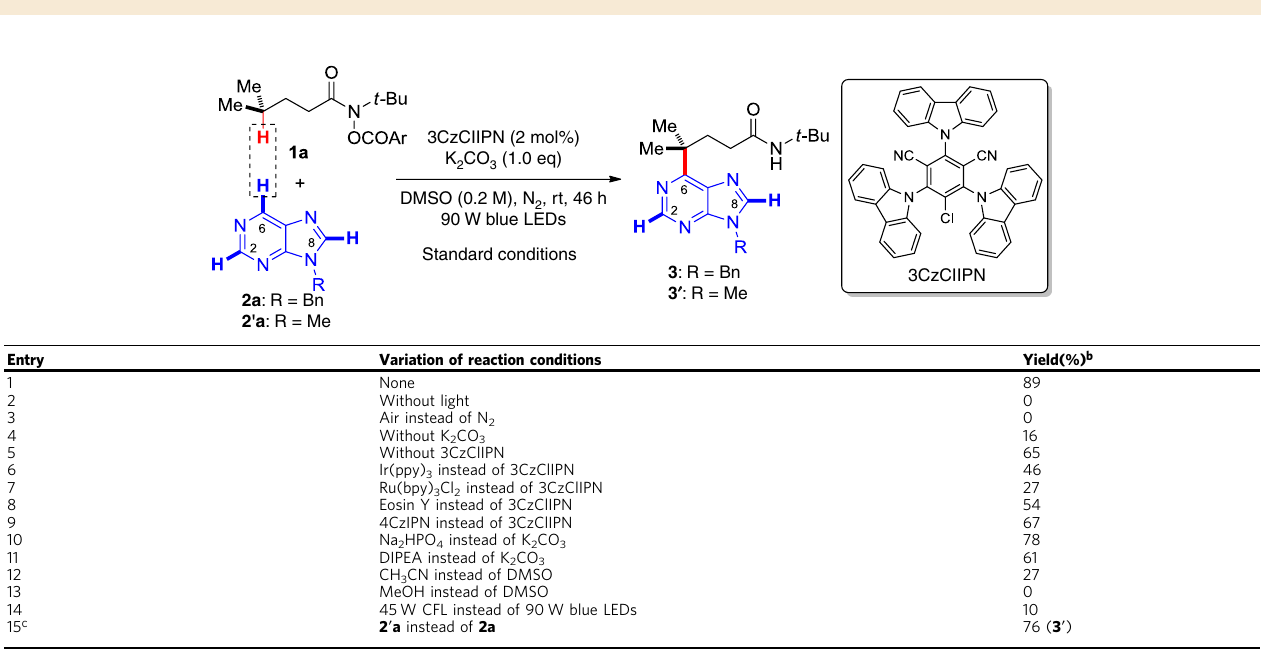
76% yield together with 8% yield of C8-alkylated regioisomer (Table 1, entry 15).